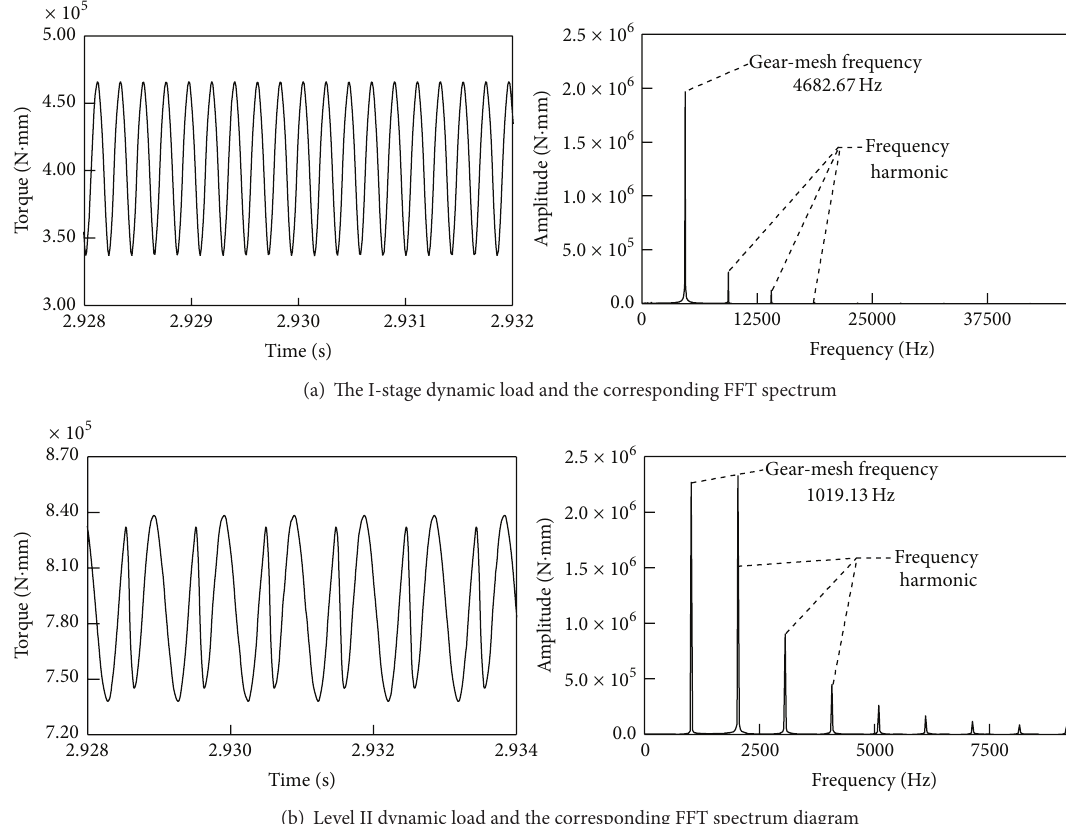
Figure 9: Dynamic load time history and FFT spectrum under standard